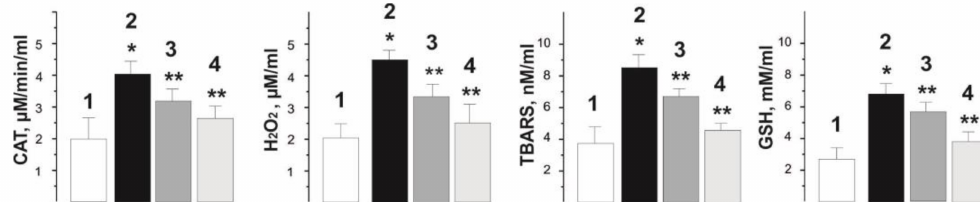
Figure 6. Indicators of pro- and antioxidant balance (CAT, H 2 O 2 , TBARS and GSH) in the blood of rats after chronic intoxication with glyphosate for 30 days. 1—control group (native muscle); 2—the glyphosate group; 3—the glyphosate+C 60 fullerene (0.5 mg/kg) group; 4—the glyphosate+C 60 fullerene (1 mg/kg) group; * p < 0.05 relative to the control group; ** p < 0.05 relative to the glyphosate